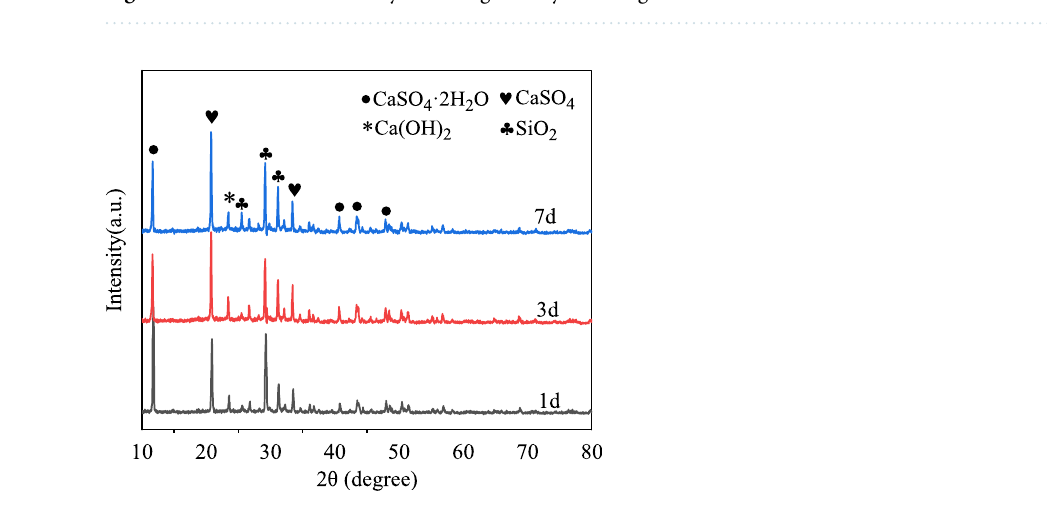
Figure 9. Influence of MSWI fly ash dosage on crystal dosage in NBFM.